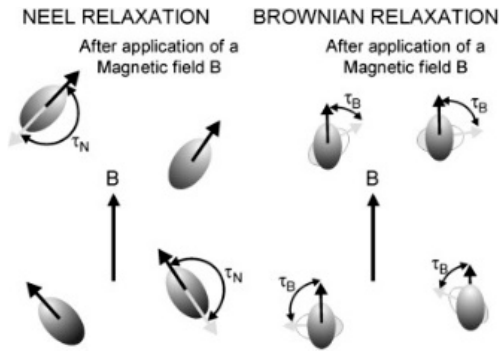
Figure 3. Angle of variation of the two components of magnetic relaxation of a magnetic [42]. In addition, the heat generated by the resistance of the magnetic material to the magnetization process by being magnetized in an external alternating magnetic field is called hysteresis heating [43]. The hysteresis line (magnetization vs. field) of a magnetic medium is shown in Figure 4. Hysteresis heating is used to be expressed in terms of the area. When the external magnetic field is sufficiently powerful it causes the rotation of the internal magnetic moment of the material to align with the external field, and the maximum magnetization strength reached in this state is called the saturation magnetization strength Ms [44]. As the magnetic field strength decreases, the spin is no longer aligned with the magnetic field and the overall magnetization strength decreases. In a ferromagnetic material, the remanent magnetic moment is maintained at zero fields. The magnetization strength at zero fields is called the remanent magnetization